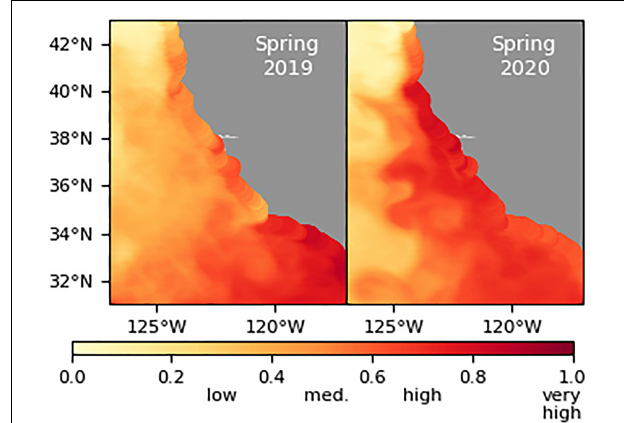
FIGURE 8 | Predicted probability of domoic acid > 500 ng/L based on the California Harmful Algae Risk Mapping model in spring 2019 and